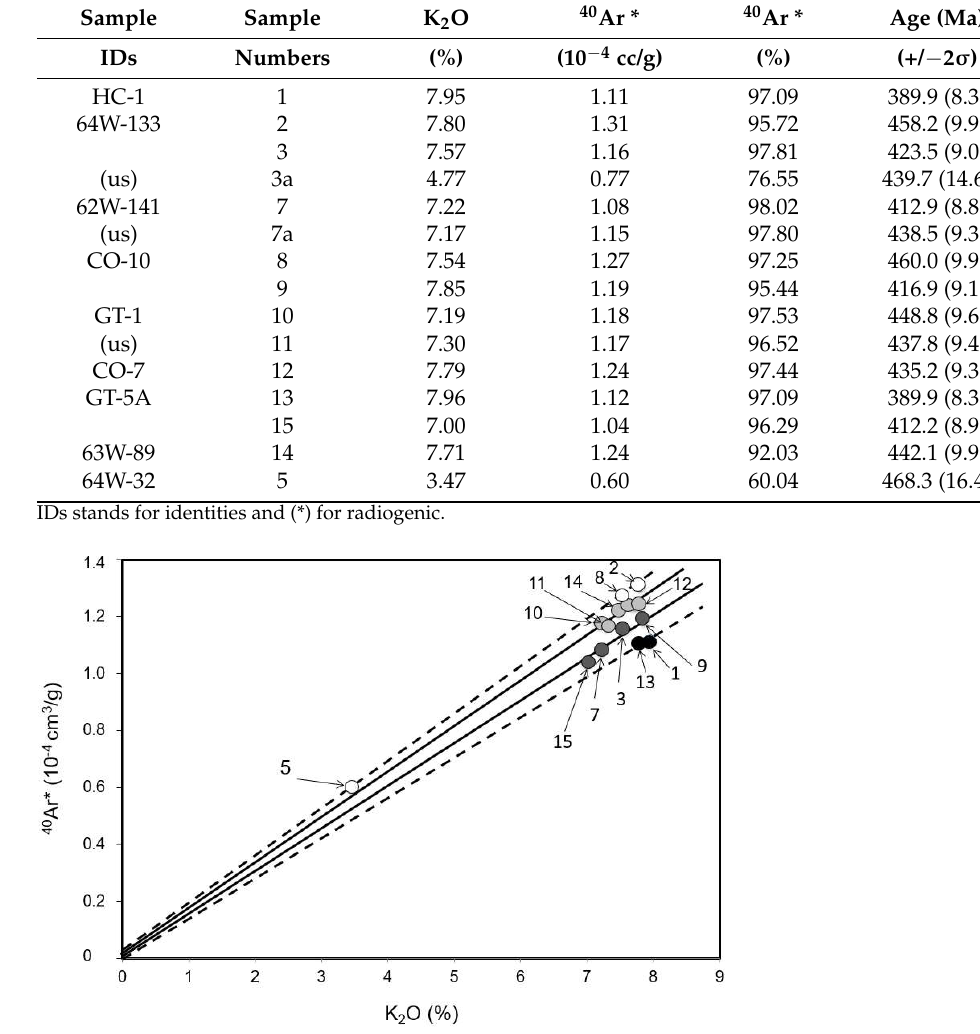
Table 4. K-Ar data of the studied glauconite-rich pellets.